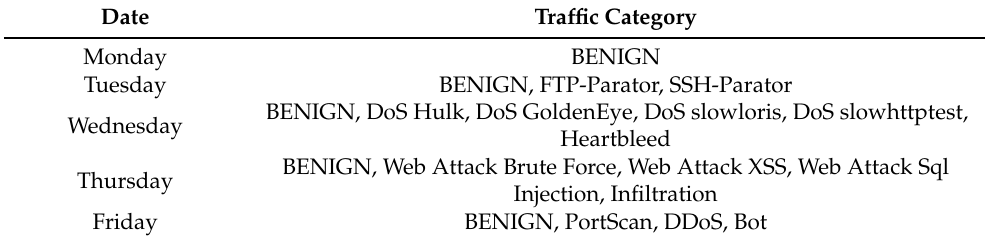
Table 1. Overview of dataset